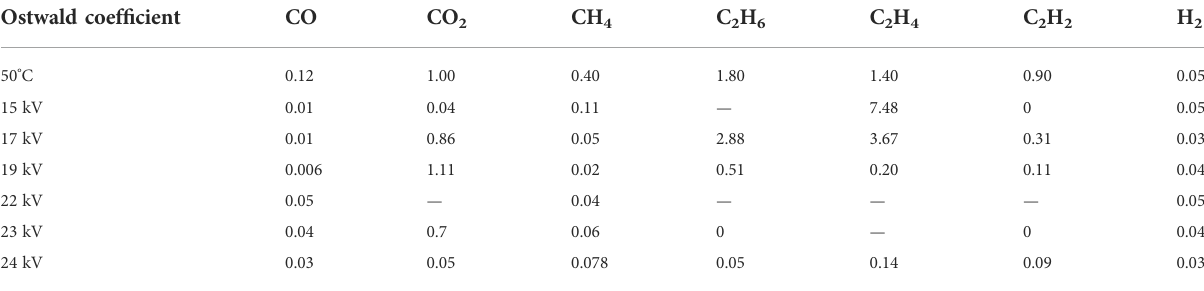
TABLE 4 Diagnostic results of three direct ratio method of dissolved gas in oil and characteristic gas on oil surface.